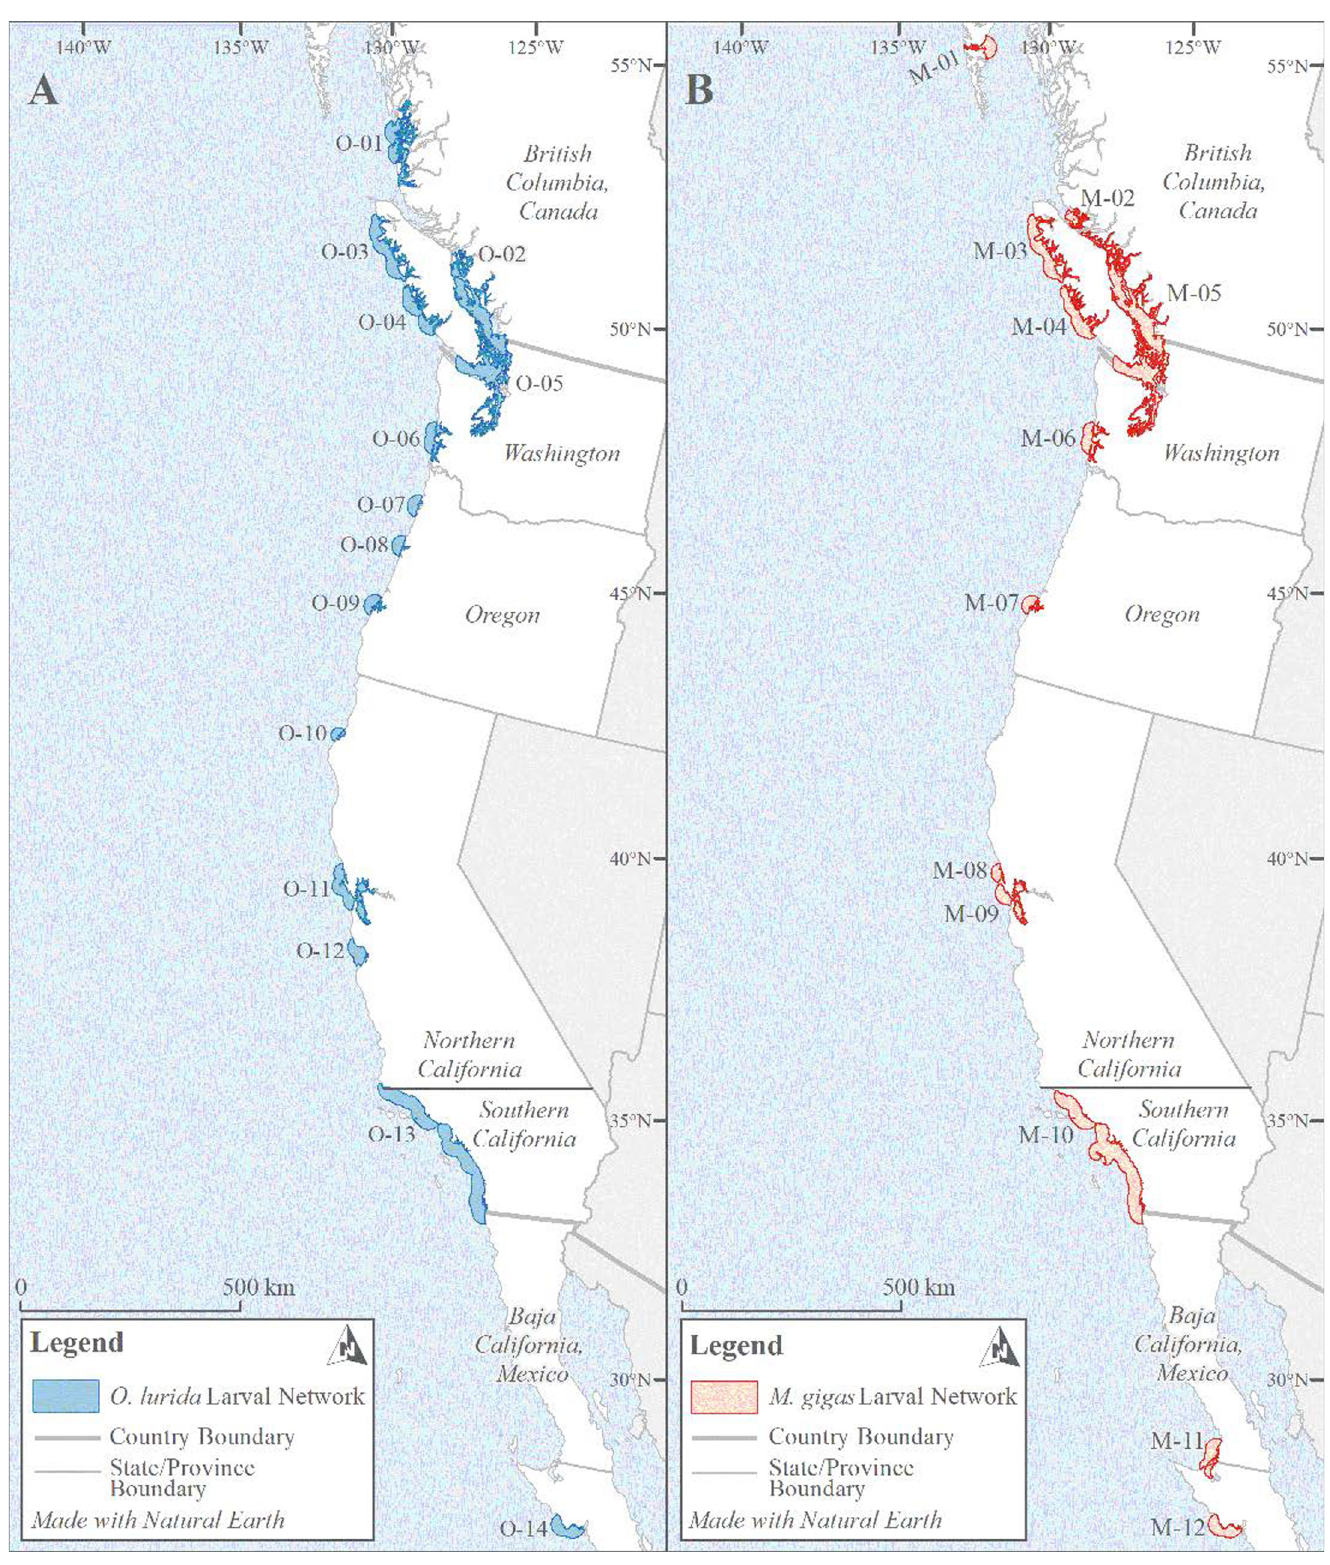
Fig 10. Coast-wide larval networks. Larval networks for O . lurida (A) and M . gigas (B) showing large larval networks in the Salish Sea to the north and in Southern California to the south. Networks are similar in size and location between species but not identical. https://doi.org/10.1371/journal.pone.0263998.g010 PLOS ONE | https://doi.org/10.1371/journal.pone.0263998 March 17,